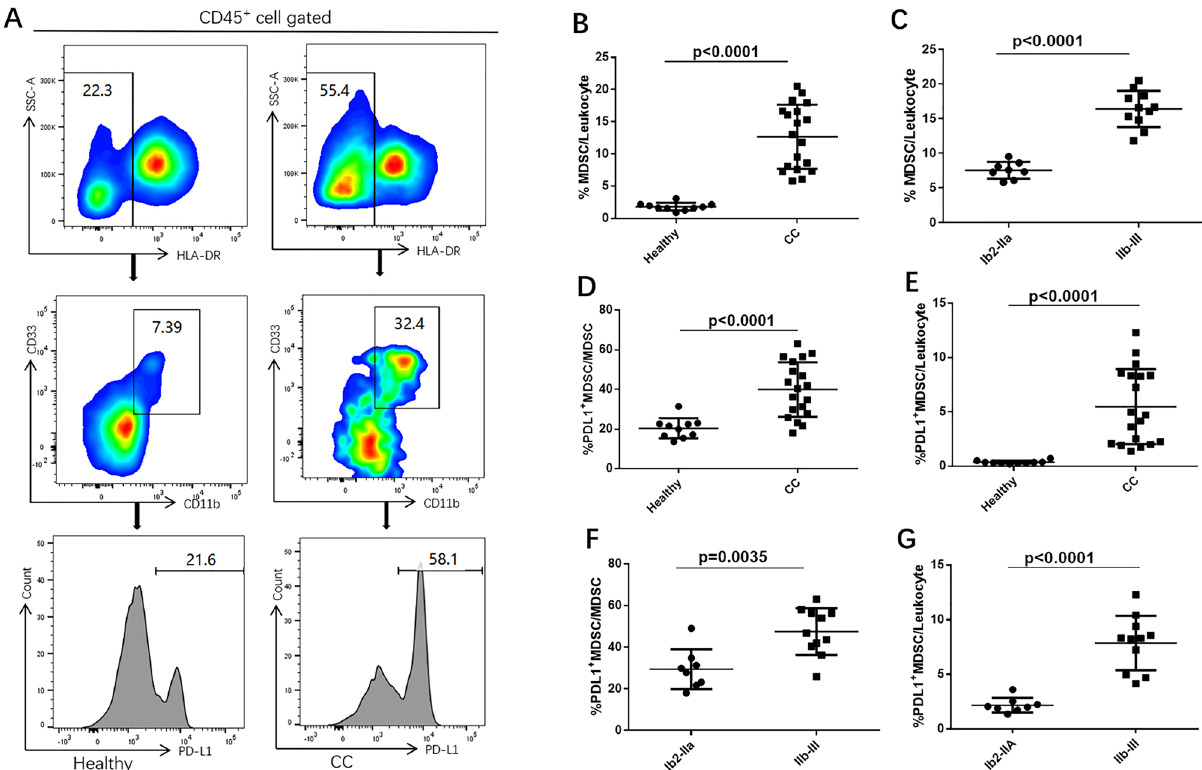
Figure 1. Tumor-infiltrating PD-L1 + MDSCs increased in cervical cancer patients. ( A ) Representative flow cytometry from a normal healthy donor (left) and a CC patient (right). ( B ) Percentages of MDSCs in CC patients were significantly higher than in healthy donors. ( C ) Percentages of MDSCs in stage IIb-III patients were significantly higher than in stage Ib2-IIa patients. ( D ) PD-L1 + cells in total MDSCs were